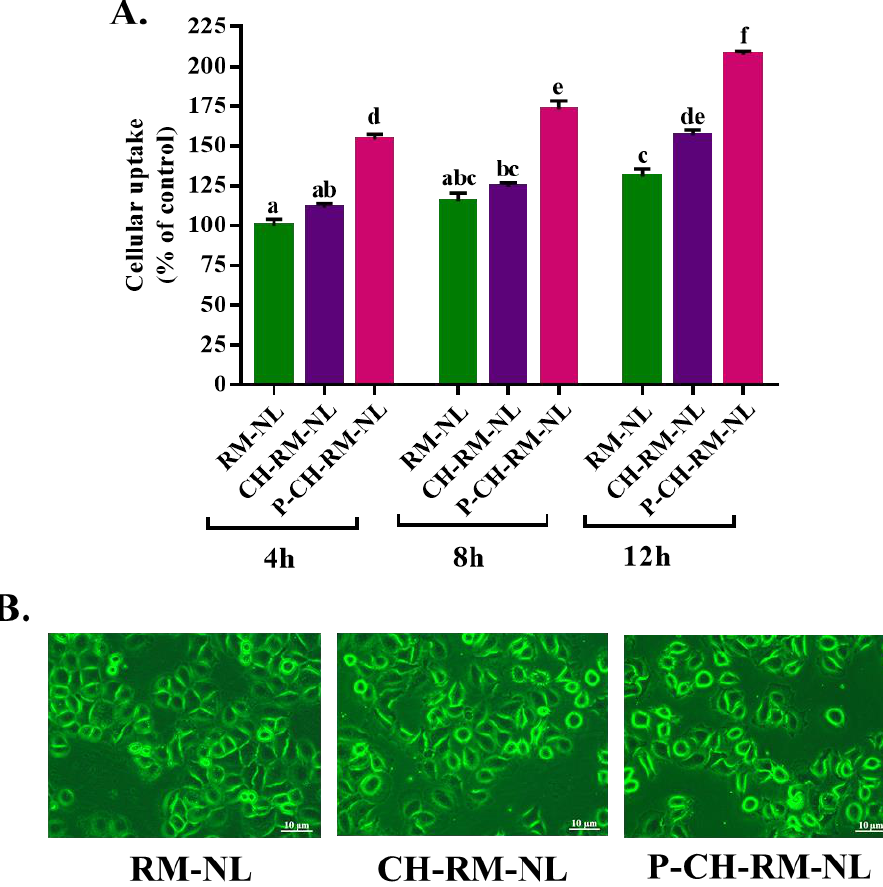
Figure 3. Cellular uptake of rhodamine 123 (RM, 5 µ M)-loaded nanoliposomes (RM-NL, CH-RM- NL, and P-CH-RM-NL) to L02 cells. L02 cells were incubated with RM-loaded nanoliposomes for 4, 8, and 12 h, accordingly ( A ) The values of fluorescence intensity of RM-loaded nanoliposomes. Individual alphabet represents the significant difference ( p < 0.05) of all treatment groups. ( B ) The photograph of fluorescence intensity of the RM-loaded nanoliposomes after 12 h of incubation. Here, RM-NL = rhodamine 123-loaded uncoated nanoliposomes; CH-RM-NL = RM-NL coated by chitosan; P-CH-RM-NL = CH-RM-NL coated by pectin.